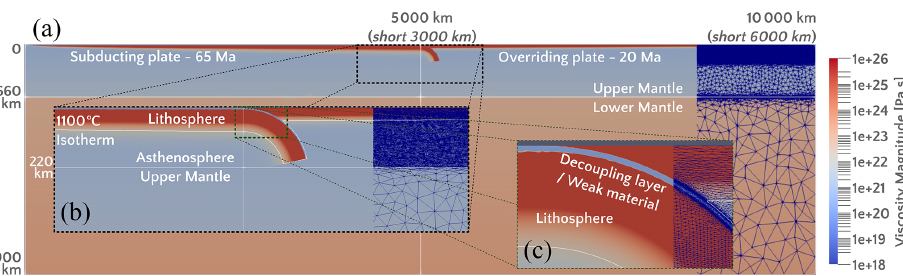
Figure 2. Model setup illustrated with the initial viscosity field of the reference long-plate model, with text indicating parameters for the reference short-plate model. Initial trench ages are indicated for the overriding and subducting plates, which have linear age variations between the ridges and the trench. Initial plate temperature is set according to half-space cooling (Turcotte and Schubert, 2002). See text for boundary conditions and further information. (a) Full model view; (b) zoom of initial slab; (c) zoom of trench and decoupling layer. The irregular adaptive mesh is presented on the right side of each panel. White lines mark the initial location of the trench (vertical line), the ULMB at 660km, the bottom of the asthenosphere (chosen at 220km) and the bottom of the lithosphere (at the 1100 ◦ C